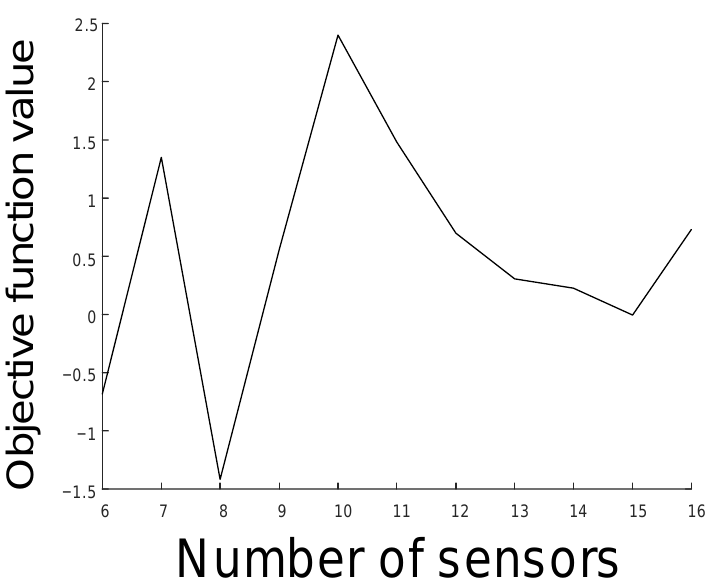
Figure 7. Objective function value for Industrial robot with the simulation model.